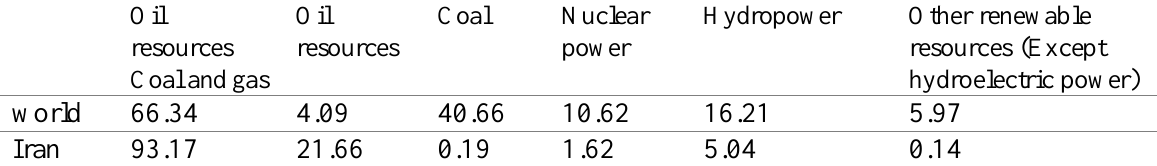
Table 1. Share of different sources of power generation in Iran and the world (2017)